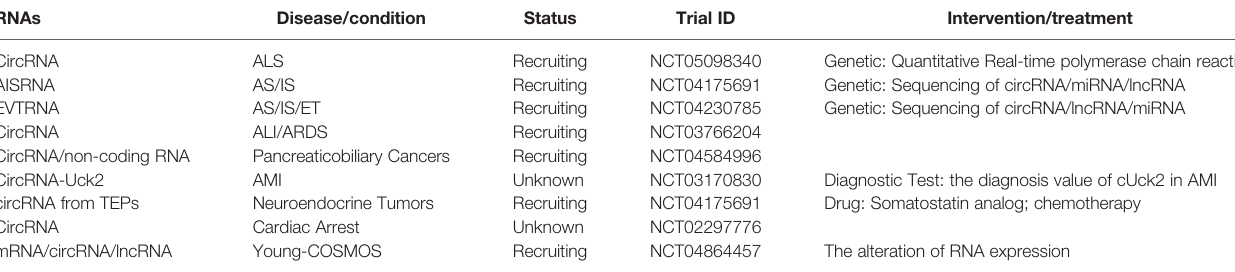
TABLE 2 | The clinical trials about circRNAs.